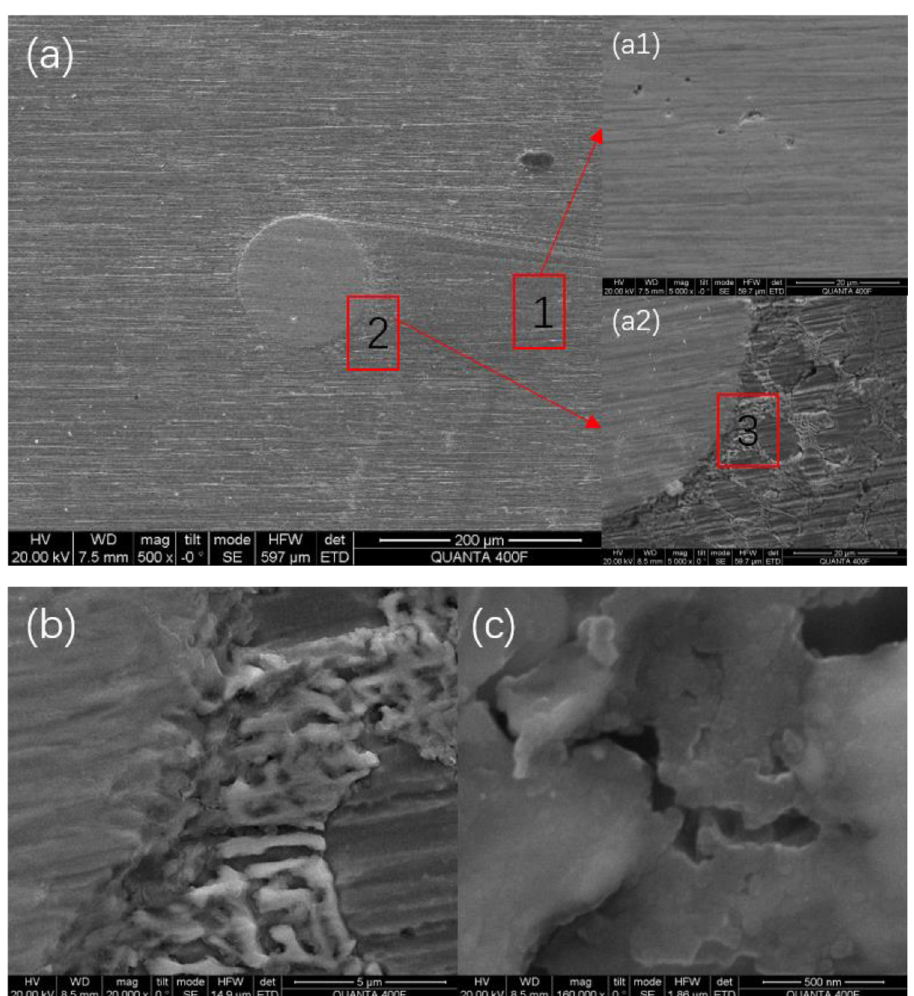
Figure 10: Low ( a ) and high ( b and c ) magni fi ed surface corrosion SEM images of Ni/WC coating exposed to 0.5 mol · L − 1 HCl solution for 30